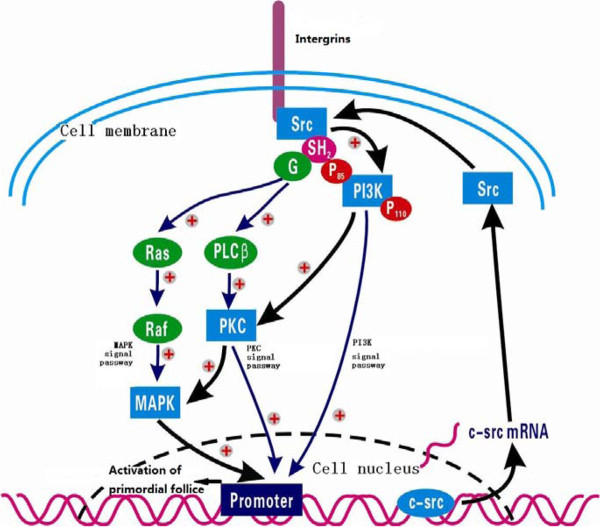
C-srcregulating primordial follicle activation and growth through PI3K → PKC → MAPK signaling pathway